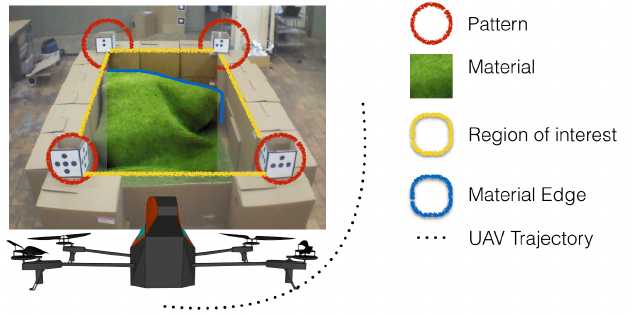
Figure 12. Experimental setup description.